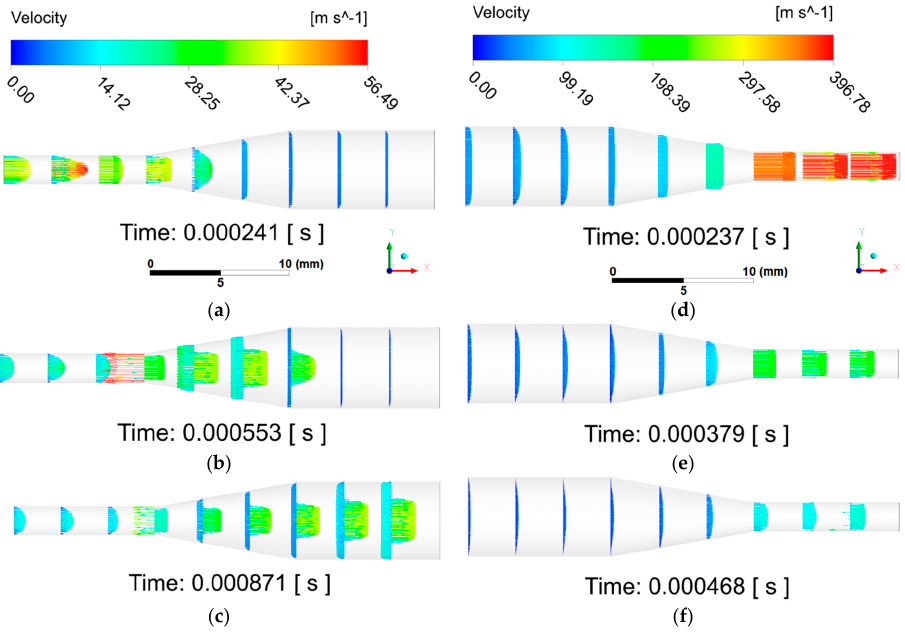
Figure 13. Velocity profile of ( a ) diffuser case in the first selected timestep, ( b ) diffuser case in the second selected timestep, ( c ) diffuser case in the third selected timestep, ( d ) confusor case in the first selected timestep, ( e ) confusor case in the second selected timestep and ( f ) confusor case in the third selected timestep.